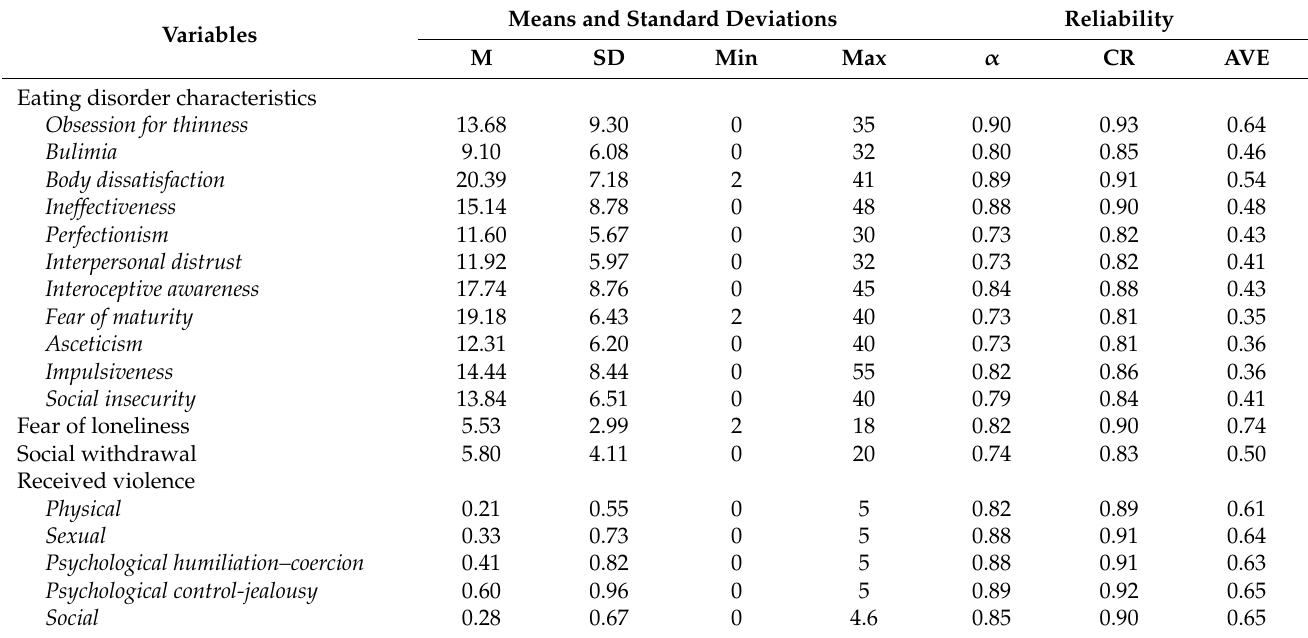
Table 1. Descriptive statistics and reliability of the study variables (n =